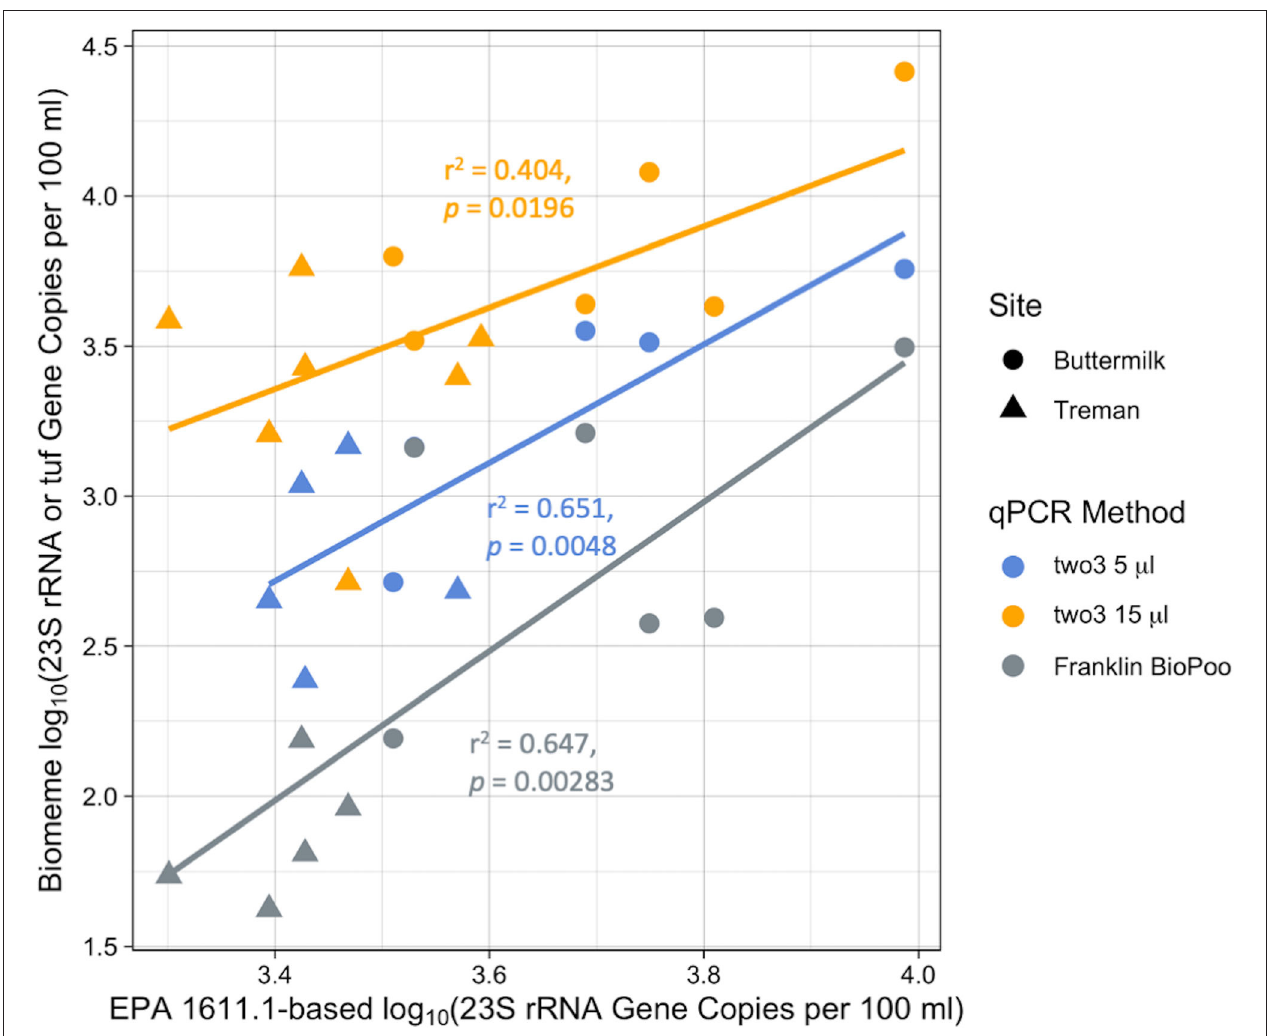
FIGURE 5 | Comparison of novel qPCR methods to the EPA 1611.1-based method for fall 2017 beach samples. log 10 -log 10 plots of Biomeme method (C1, two3-5 µ l; C2, two3-15 µ l; and C3, BioPoo) results as compared to EPA-based method. The BioPoo assay quantifies the tuf gene while all other assays quantify the 23S rRNA gene for Enterococcus